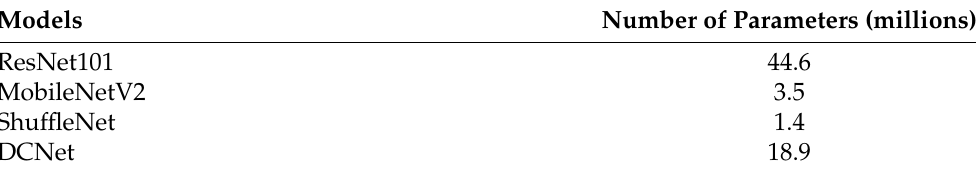
Table 5. Comparison of learning parameters with baseline CNN